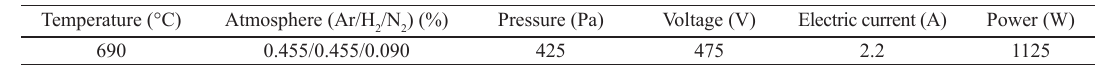
Figure 1. Creep specimen (dimensions in mm) 13 . Table 1. Parameters applied in the plasma nitriding.